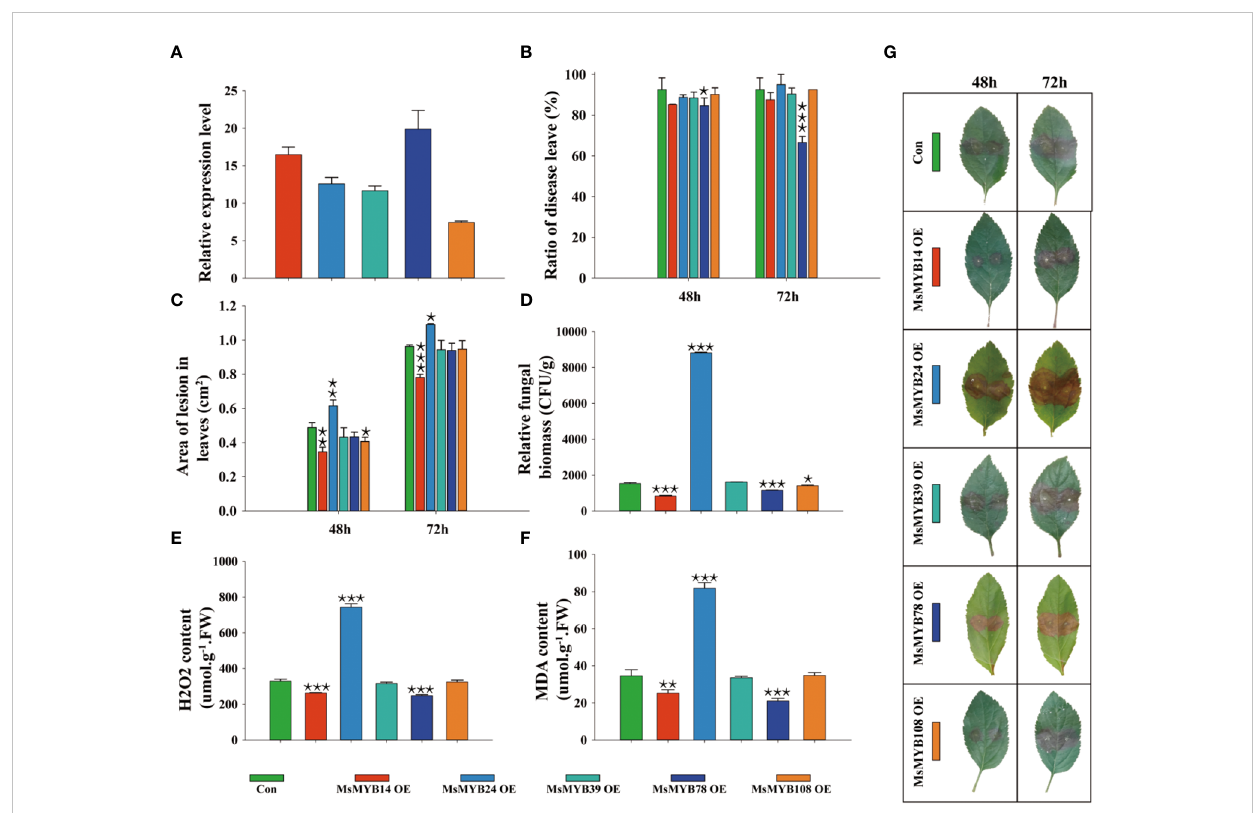
FIGURE 7 Functional identi fi cation of MsMYB family members in Malus sieversii in response to infection by Valsa mali . (A) Relative expression levels of MsMYBs in transiently transformed leaves determined by qRT-PCR at 72 h after infection by V. mali . The Valsa canker disease resistance of fi ve MsMYBs is compared to that of the control. The lesion ratio (B) and area (C) were measured from detached leaves at 48 h and 72 h Each sample contained three or more independent biological replicates. One-way ANOVA was used for signi fi cances comparison with the control leaves (Con). (D) Relative fungal biomass of transiently transformed leaves of wild apple after 72 h of infection by V. mali . (E) H 2 O 2 content in transiently transformed leaves of wild apple after 72 h of infection by V. mali . (F) MDA content in transiently transformed leaves of wild apple after 72 h of infection by V. mali . (G) The phenotype of transiently transformed leaves in wild apple changes following V. mali infection. One asterisk indicates a signi fi cant difference between treatment and control plants (p ≤ 0.05). Two asterisks indicate an extremely signi fi cant difference between treatment and control plants (p ≤ 0.01). Three asterisks indicate an extremely signi fi cant difference between treatment and control plants (p ≤